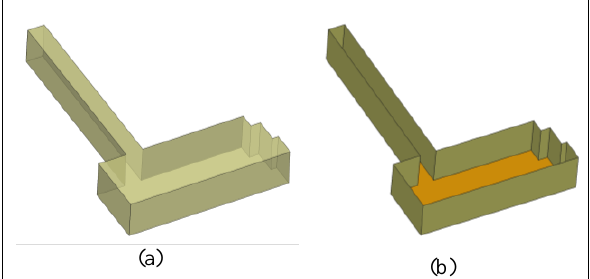
Figure 13. Final model of the interior space obtained by iteratively applying the merge rule to the cuboids. The model is shown as a solid with transparent faces (a), and as converted to B-rep with the ceiling removed to provide a better view of the interior